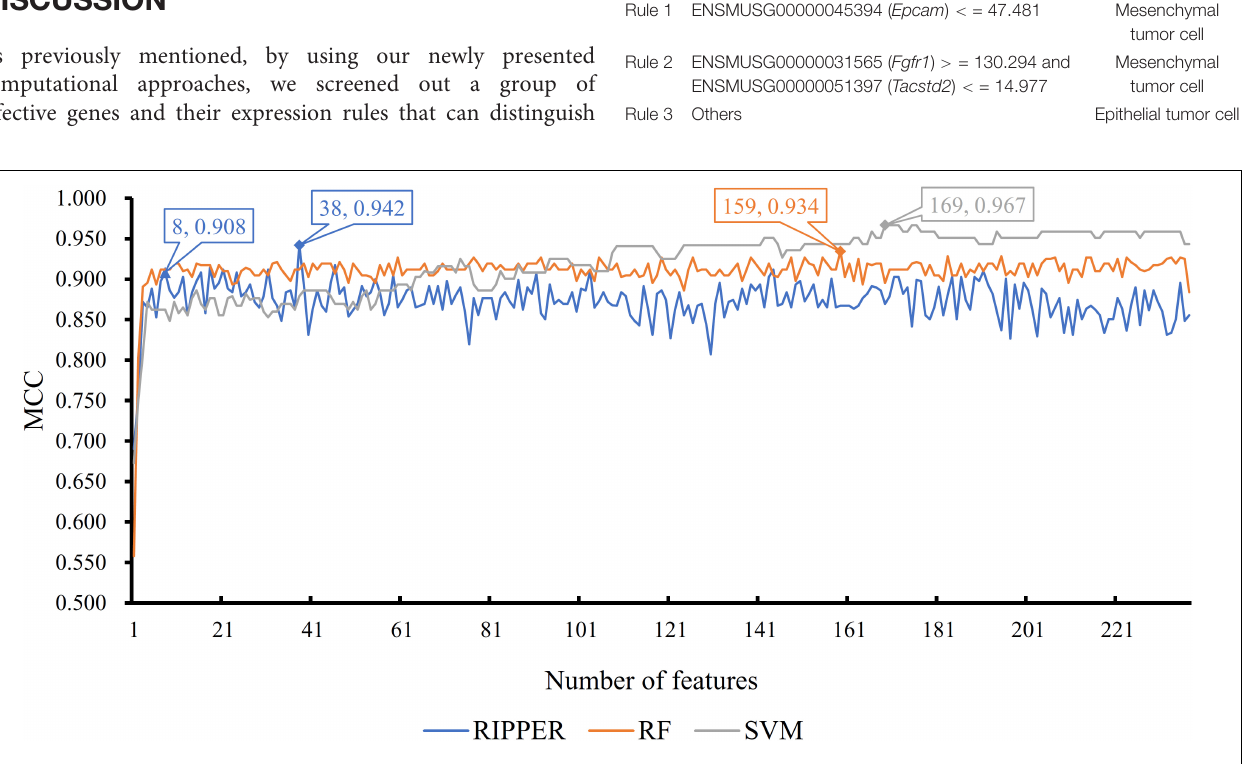
FIGURE 2 | Incremental feature selection (IFS) curve of different classifiers. For each curve corresponding to one method, two performance peaks are annotated to indicate the number of optimal features selected and the accuracy of their classification model.